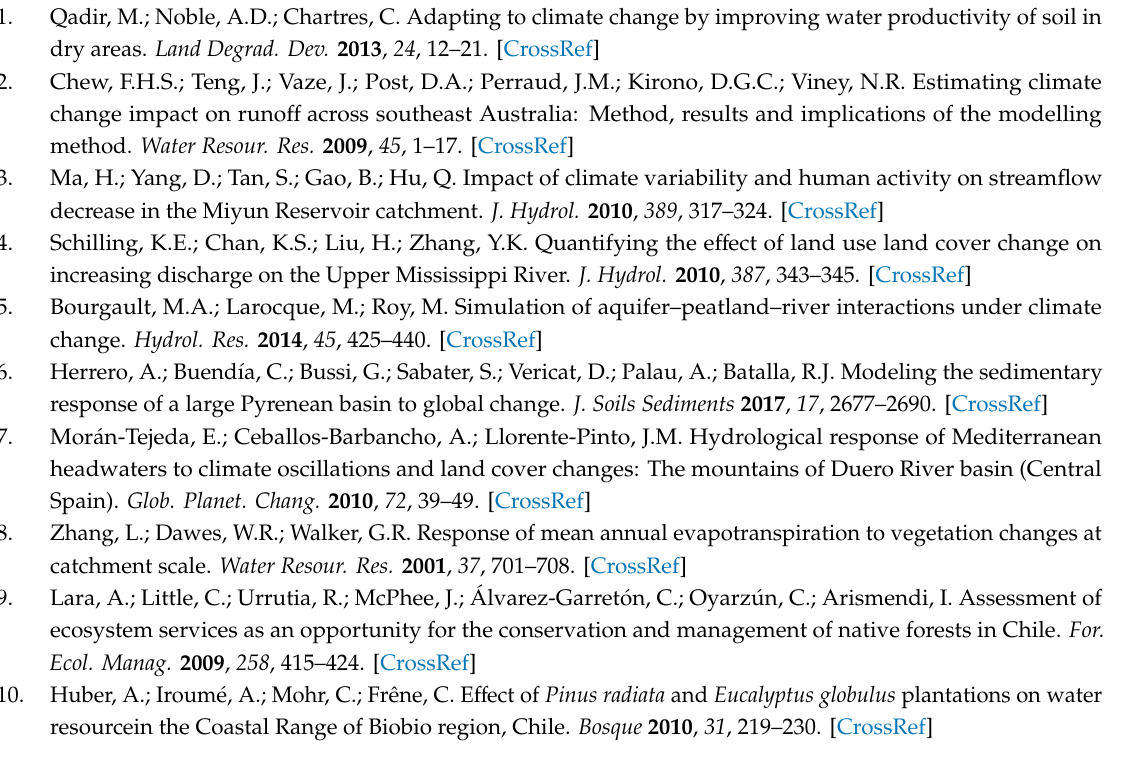
Figure S1:Additional supporting information of the three land cover scenarios, Figure S2: Additional supporting information of the Figure 3 (all catchments), Figure S3: Additional supporting information of the Figure 4 (all catchments), Figure S4: Additional supporting information of the Figure 5 (all catchments), Table S1: Summary of hydroclimatic scenarios with selected increments of precipitation and potential evapotranspiration used on modelling exercises ( ± for reference standard deviation is also shown), Table S2: Modelling results for each of the studied catchments together with forest management and physiographic information, Table S3: Characterization of catchments hydrology, Table S4: Observed (Q o ) and simulated (Q s ) runo ff yield under land use scenarios (% of change) for the two calibration